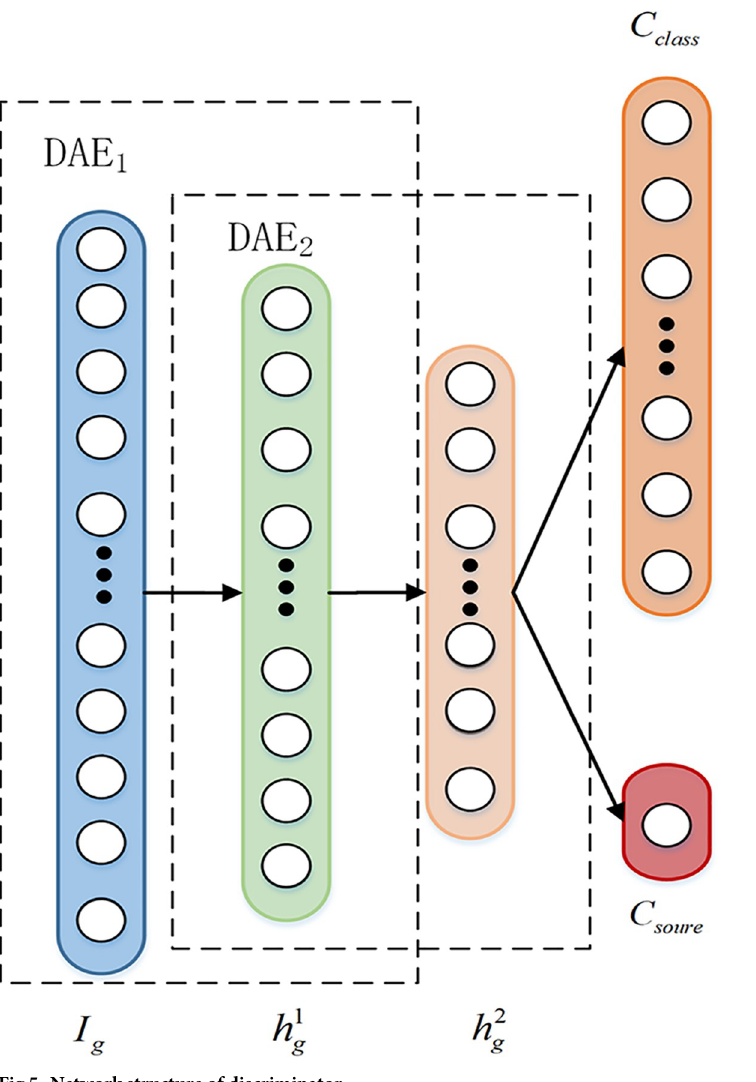
Fig 5. Network structure of